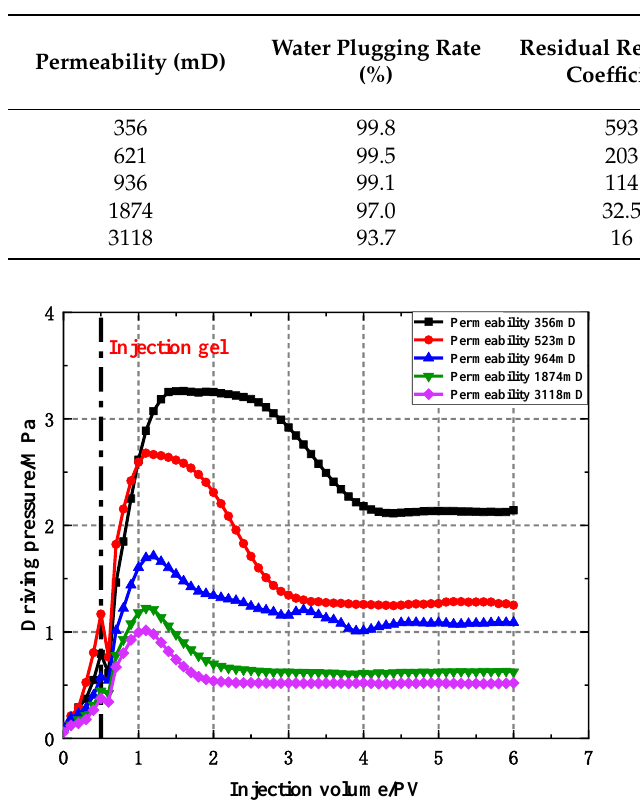
Figure 10. Experimental diagram of the influence of permeability on plugging performance.